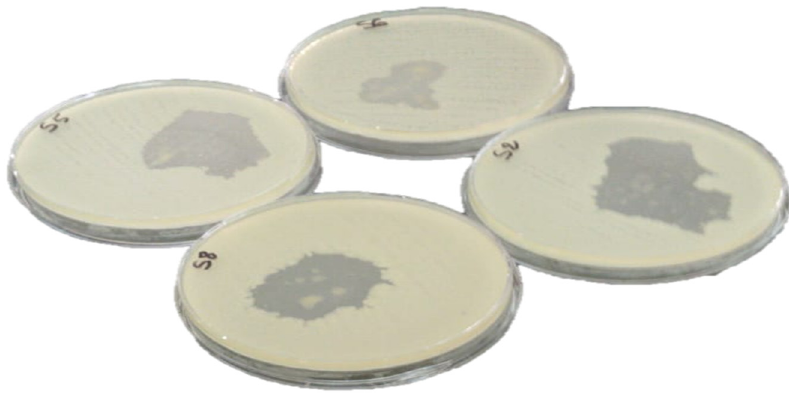
Figure 2. Bacterial strain growth inhibition zone of C. ladanifer essential oil.